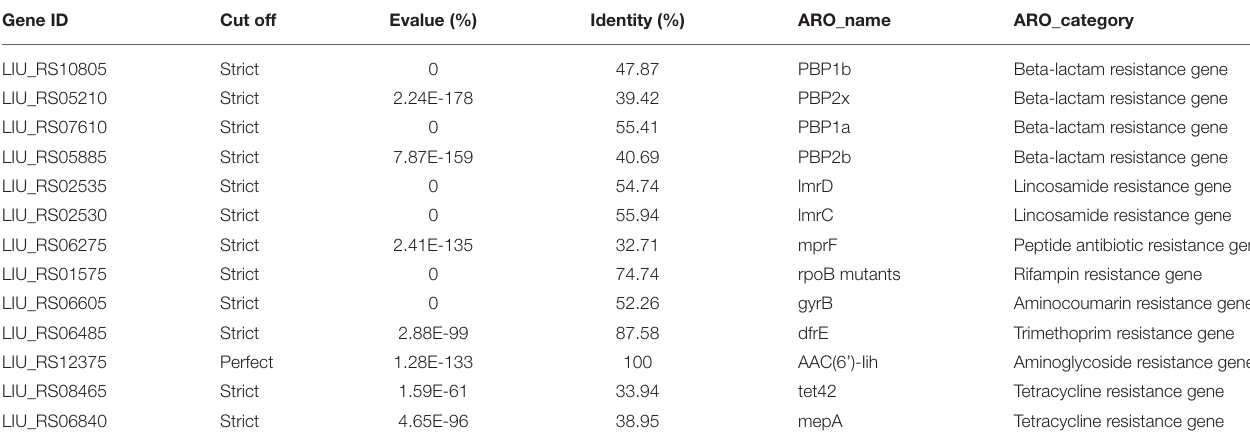
TABLE 1 | Putative antibiotics resistance genes in the Enterococcus durans KLDS6.0930 genome by searching with the CARD.